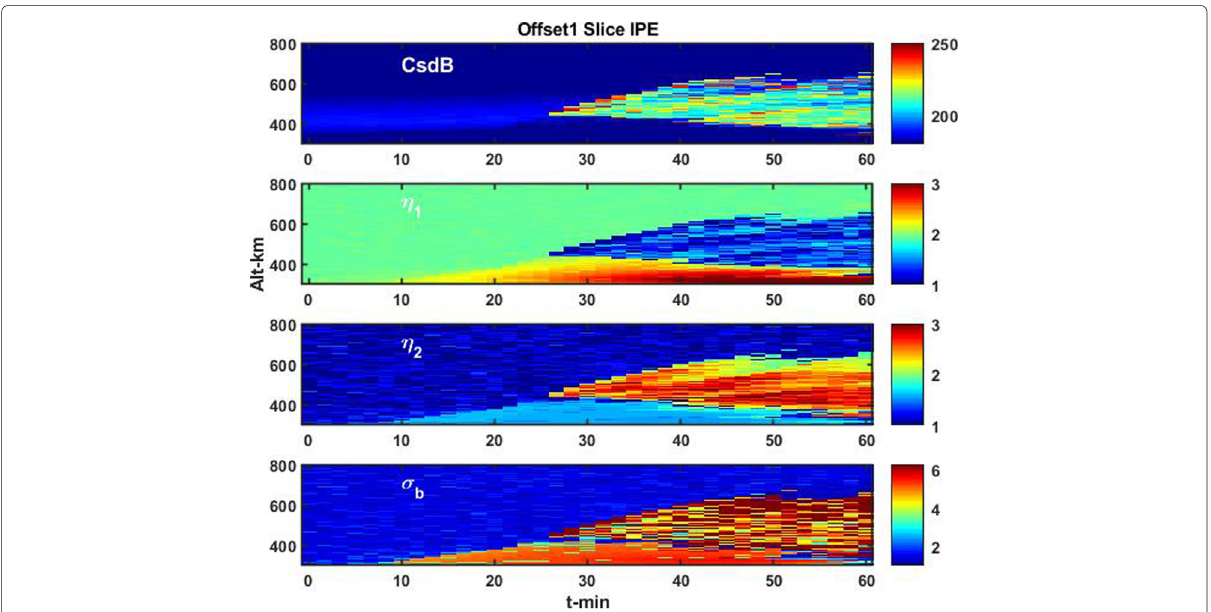
Fig. 9 MLE-IPE SDF parameter estimates from offset1 slice plane realizations at 100 s, where σ b = 2 π/ q 0